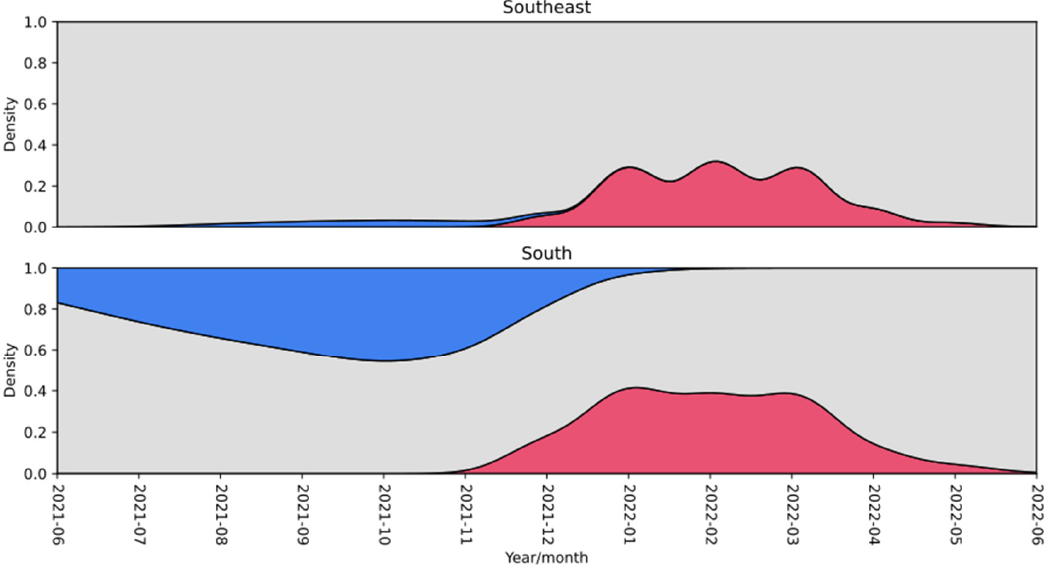
Figure 4. Density plot of the frequencies of AY.101 (Delta) and BA.1.1 (Omicron) lineages circulating in Brazil between June 2021 and June 2022. Both lineages co-circulated mainly in December 2021 in South Brazil. The colour of the lineages is shown in the legend.